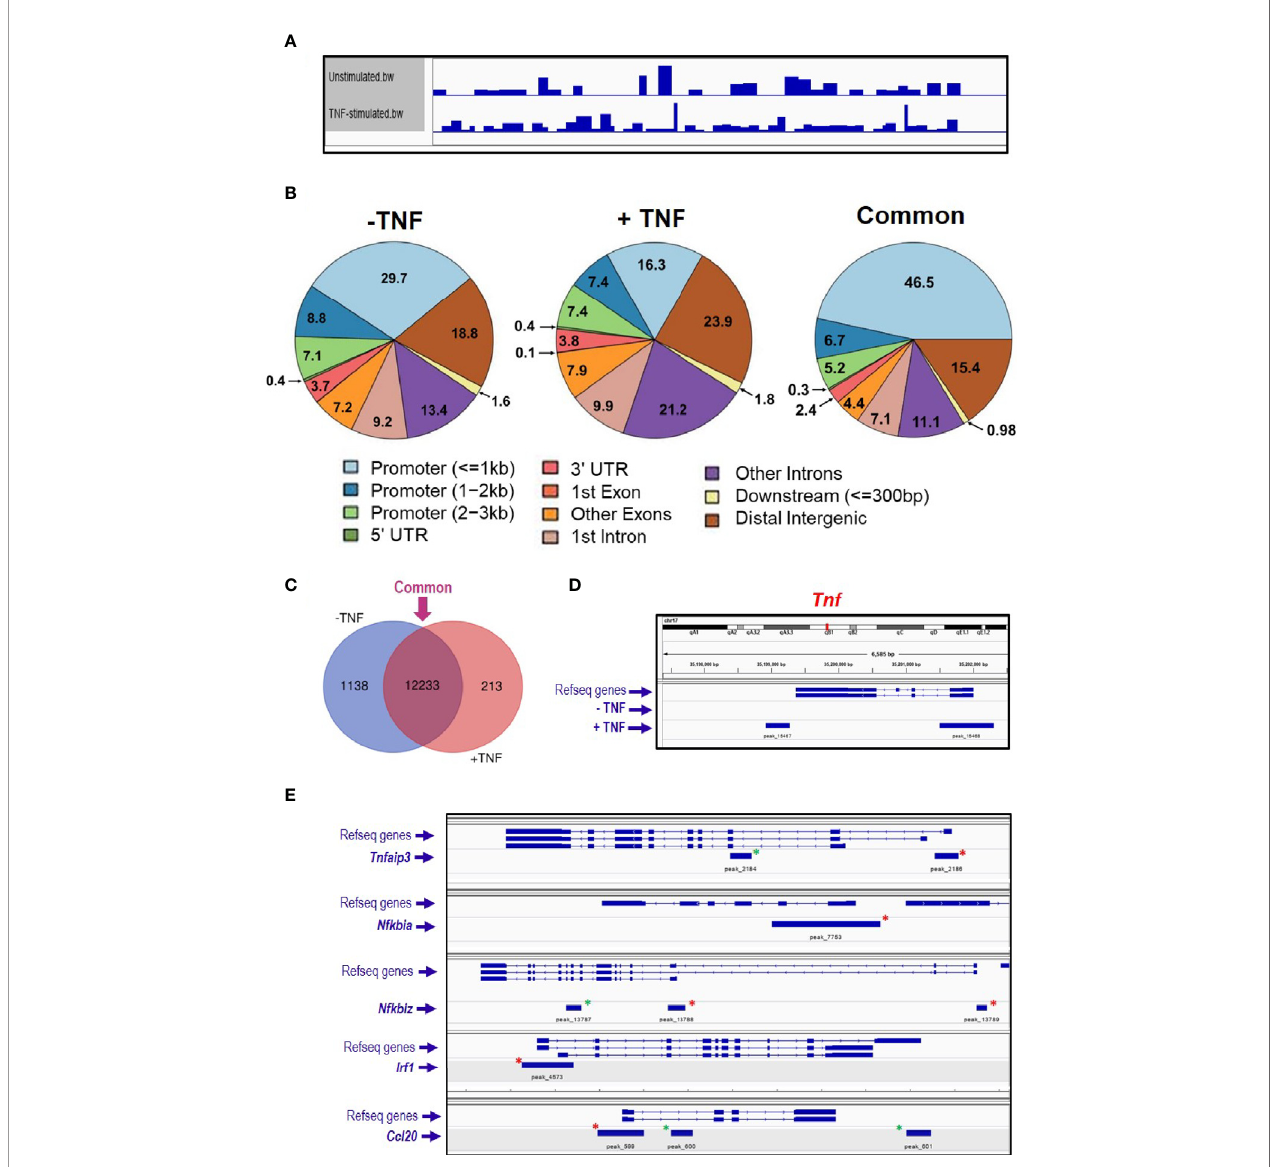
FIGURE 1 | ATAC sequencing analysis of TNF-stimulated enteroids. Enteroid cultures were left unstimulated or were stimulated with 40 ng/ml TNF for 2 h. DNA isolated from these cultures was further processed, ampli fi ed by PCR, and DNA sequencing followed by informatics analysis. (A) Genome coverage in both experimental conditions analysed, and (B) charts illustrating the percentage of annotated peaks identi fi ed within different genomic regions, with percentages shown to one decimal place. Informatics analysis grouped the peaks into three groups; 1) unstimulated only ( − TNF), 2) TNF-induced only (+ TNF) and 3) ‘ common ’ , which refers to peaks in both the unstimulated and stimulated sample. (C) Venn diagram comparing the unstimulated and stimulated samples, illustrating the number of identi fi ed genes as having open chromatin in their promotor. Venn diagram software from Ghent University, freely available at http://bioinformatics.psb.ugent.be/ webtools/Venn/. (D) Tnf locus and peak annotation in unstimulated and stimulated conditions. (E) . Five classical NF k B signaling pathway genes identi fi ed by ATAC- sequencing as having open chromatin loci. Green asterisks indicate annotated peaks unique to the stimulated sample. Red asterisks highlight the peaks ‘ common ’ to both